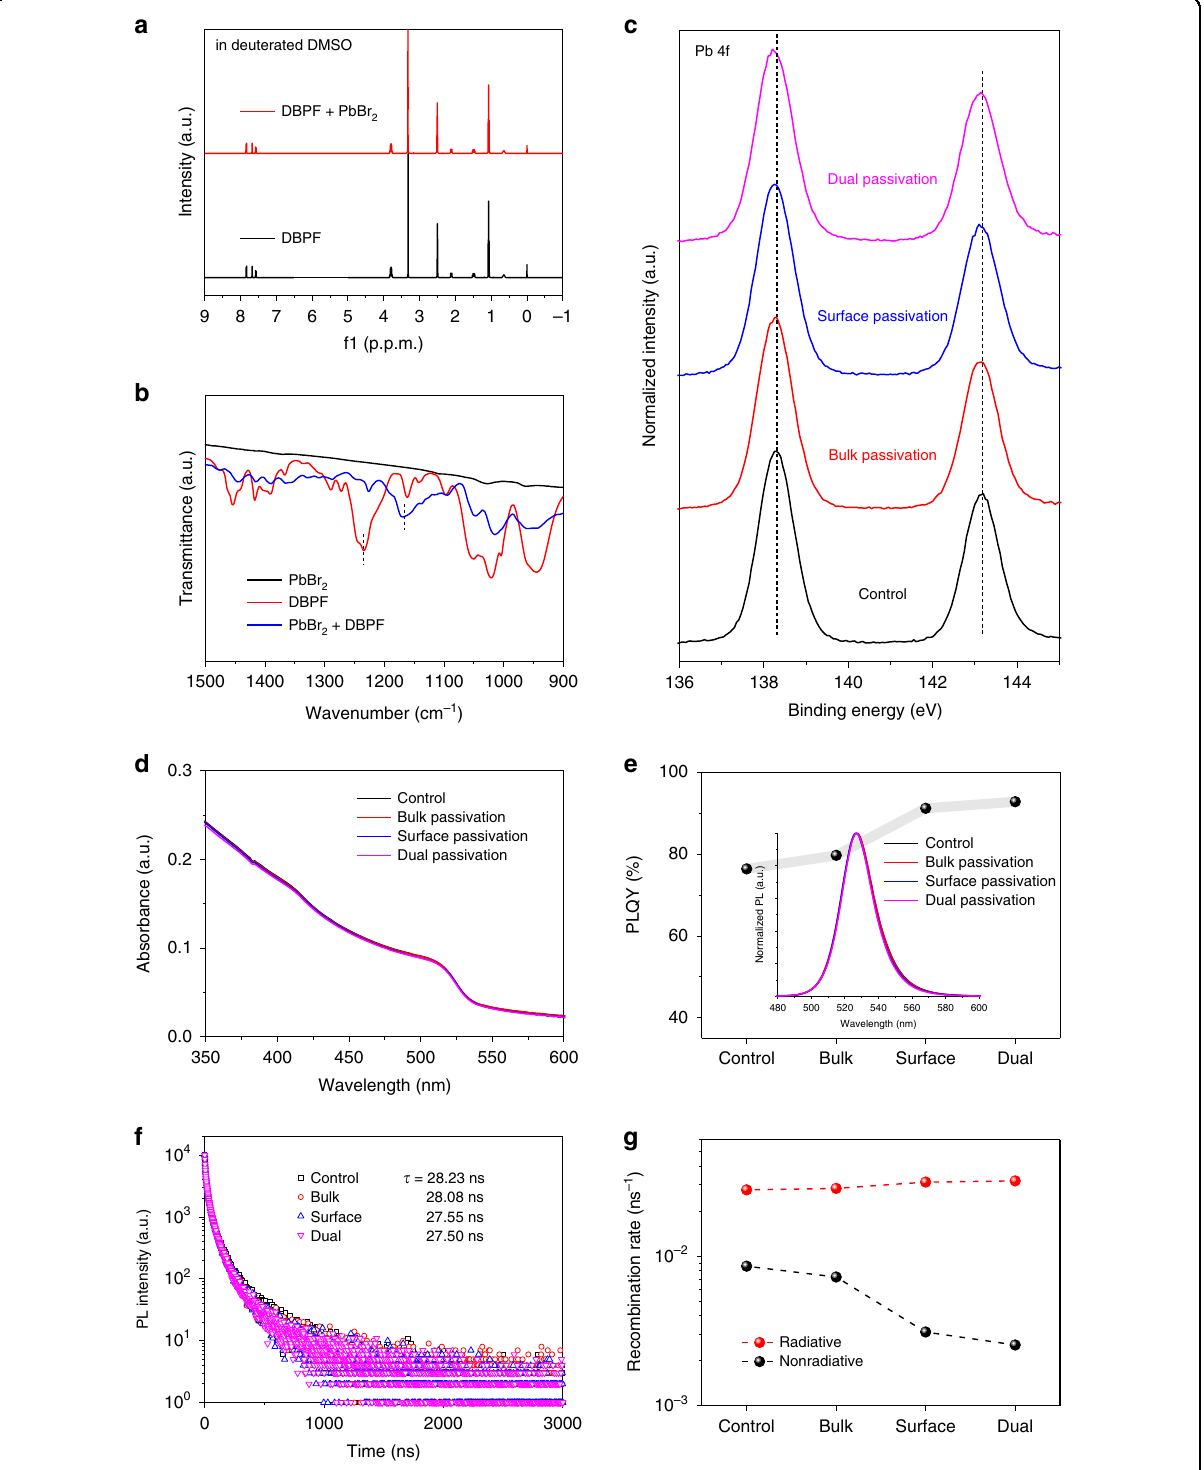
Fig. 3 Working mechanism of DBPF. a 1 H NMR spectra of DBPF without and with PbBr 2 dissolved in deuterated DMSO. b FTIR spectra of PbBr 2 , DBPF, and DBPF with PbBr 2 . c XPS of Pb 4 f peaks, d light absorbance spectra, e PLQY values and normalized PL spectra, f PL-decay curves, and g recombination rates of perovskite fi lms without and with different passivation